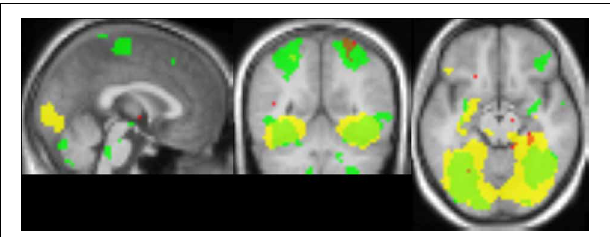
FIGURE 10 | Comparison of adaptation contrasts to the contrast in activation between perception of intact and smoothed images. The contrast between material adaptation (same material, different image) and baseline adaptation (same image) is shown in green. The contrast between no adaptation (different materials) and material adaptation is shown in red. The contrast between perception of intact and smoothed images is shown in yellow. A contrast threshold of t = 3 . 00 was used at MNI-coordinates x = 0, y = − 55, z = − 13. There is a striking overlap between the contrast between material adaptation and baseline adaptation, and the contrast between intact and smoothed